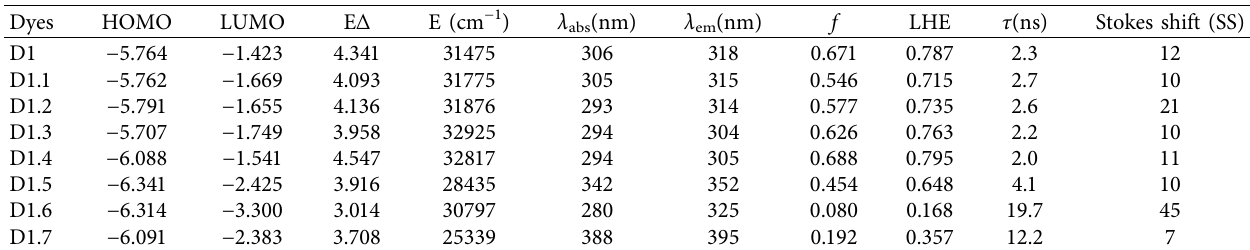
Table 4: The calculated excitation energy (E), absorption wavelengths ( λ max ), emission wavelength ( λ em ), emission oscillator strength ( f ), light harvesting efficiency (LHE), excited-state lifetime ( τ ), and Stokes shift (SS) of dye D1 and its derivatives (D1.1-D1.7) in a DMSO solvent medium. They were calculated by using the TD-B3LYP/6-311++G ∗∗ level of